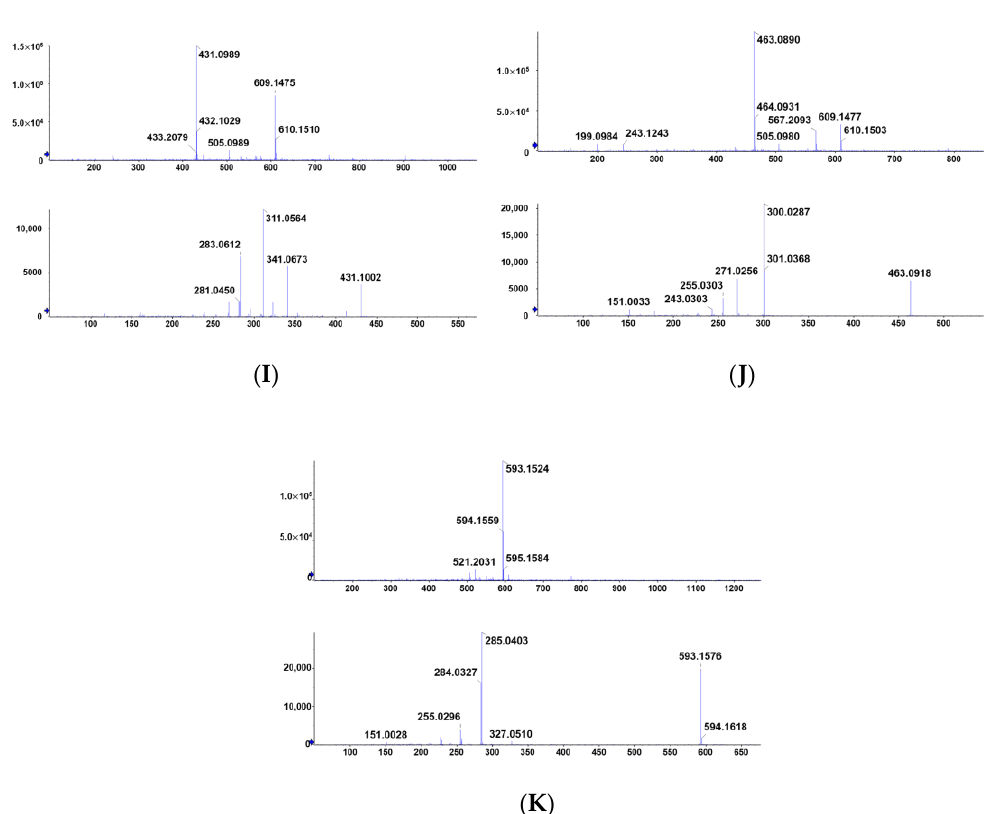
Figure 6. The mass spectrometry of flavonoids compounds. ( A ) 3-O-(rhamnopyranosyl-glucopyranosyl)-7-O-(glucopyranosyl)-quercetin; ( B ) 2-carboxyl-1, 4-naphthohydroquinone-4-O-glucopyranoside; ( C ) luteolin 6-C-glucopyranoside, 8-C-arabinopyranoside; ( D ) schaftoside; ( E ) isoorientin; ( F ) isoschaftoside; ( G ) rutin; ( H ) 2”-O-rhamnosylvitexin; ( I ) isovitexin; ( J ) isoquercetin; ( K ) kaempferol-3-O-rutinoside.